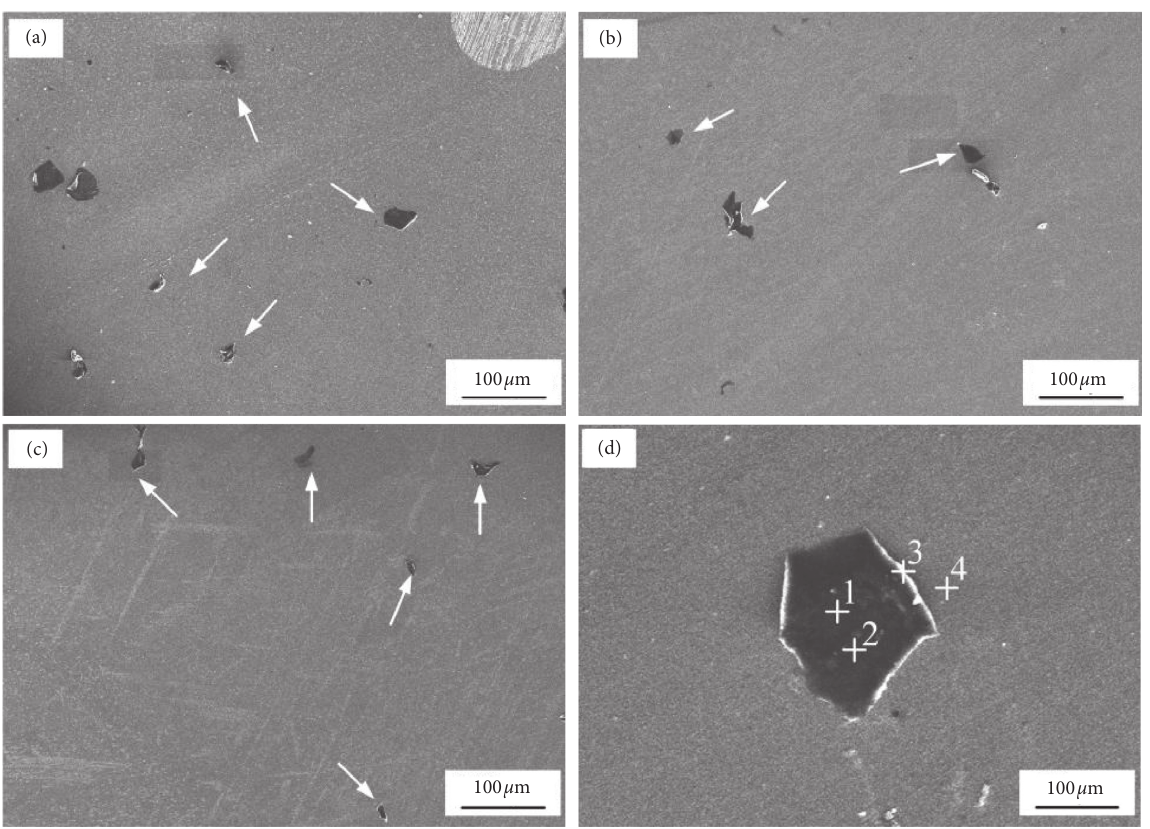
Figure 8: Surface morphology of specimens and EDS measuring locations near the corrosion pit after electrochemical corrosion tests: (a) base material, (b) stir zone obtained at 30mm/min, (c) stir zone obtained at 50mm/min, and (d) EDS measuring Table 4: Elements contents at different locations in Figure 8(d) measured by EDS.